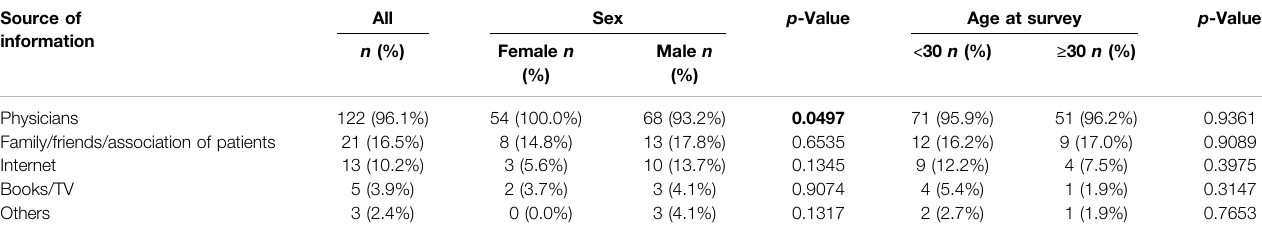
TABLE 2 | Comparison of source of information on ustekinumab (UST).